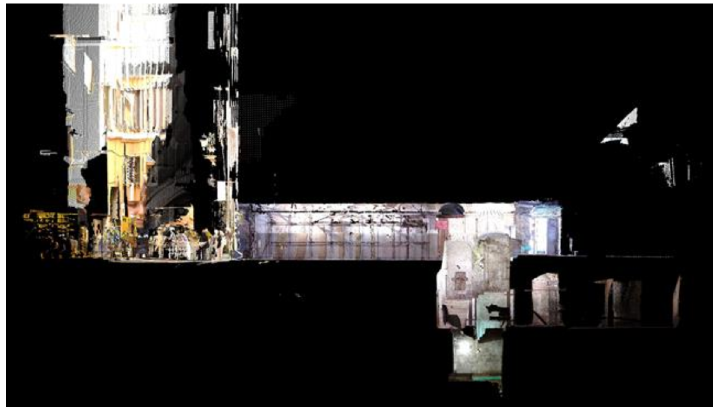
Figure 5. Assembled point cloud, section